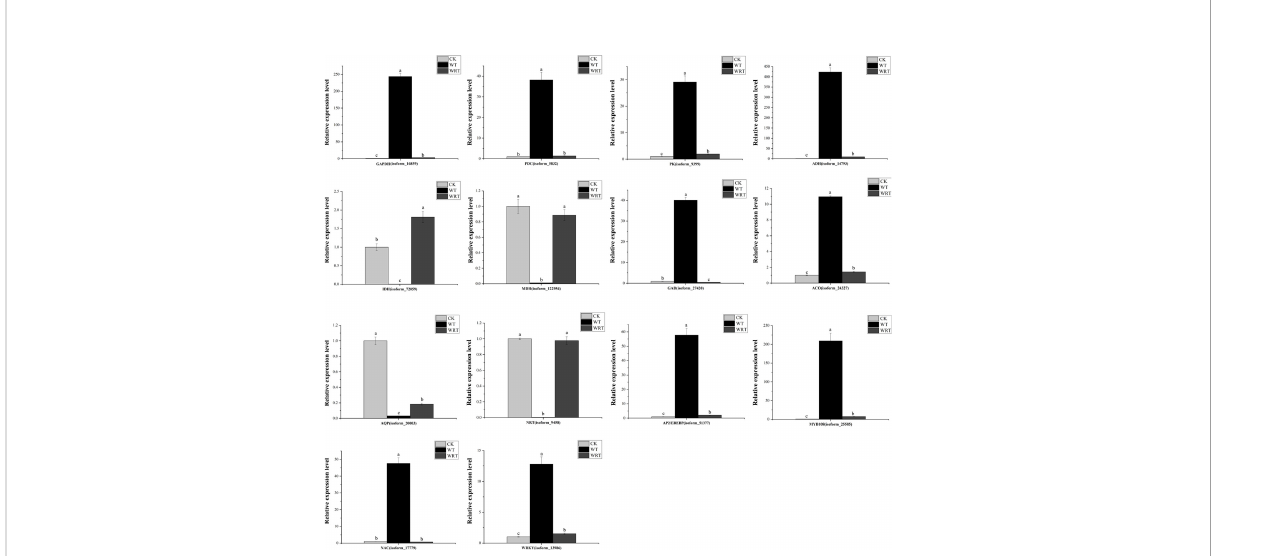
FIGURE 8 Quantitative real-time PCR validation of key genes. Actin was used as the reference gene. Expression values were normalized such that the expression levels of CK were set to 1. GAPDH, glycer-aldehyde-3-phosphate dehydrogenase; PK, pyruvate kinase; PDC, pyruvate decarboxylase; ADH, alcohol dehydrogenase; MDH, malate dehydrogenase; IDH, isocitrate dehydrogenase; GDH, glutamate decarboxylase; ACO, 1- aminocyclopropane-1-carboxylate oxidase; AQP, aquaporin; NRT, nitrate transporter. Values represent mean ± standard deviation (SD), and letters indicate signi fi cant differences according to Duncan ’ s multiple range test ( p <